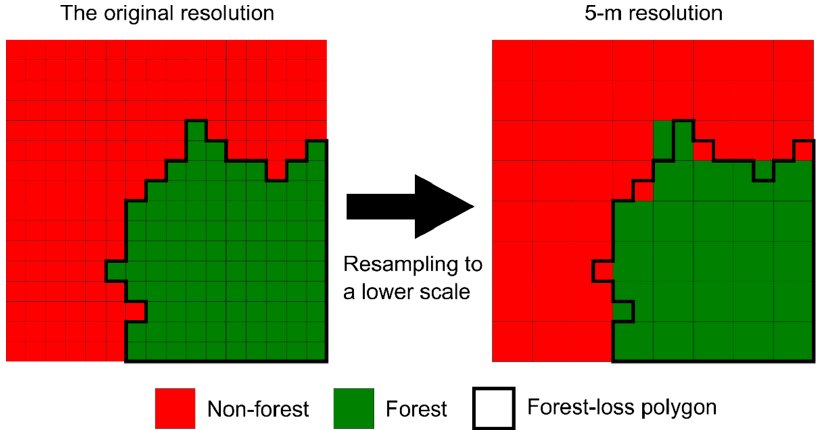
Figure 3. Schematic illustration of a forest-loss polygon including non-forest. Four percent of the forest-loss polygon in this figure is covered with non-forest with lower resolution land classification map.